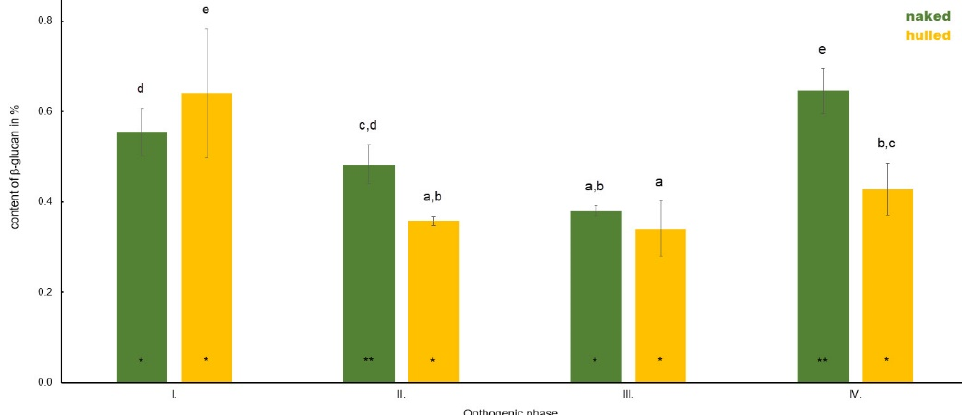
Figure 7. Comparison of the content of β -D-glucan in the leaf of hulled and naked oat samples during plant ontogenesis. Different letters indicate a statistically significant difference between individual seed types (naked and hull) in specific ontogenetic phase evaluated by ANOVA (LSD, p ≤ 0.05). Star symbols (* and **) represent statistically significant difference between naked and hulled samples evaluated for each ontogenetic phase individually by ANOVA (LSD, p ≤ 0.05).